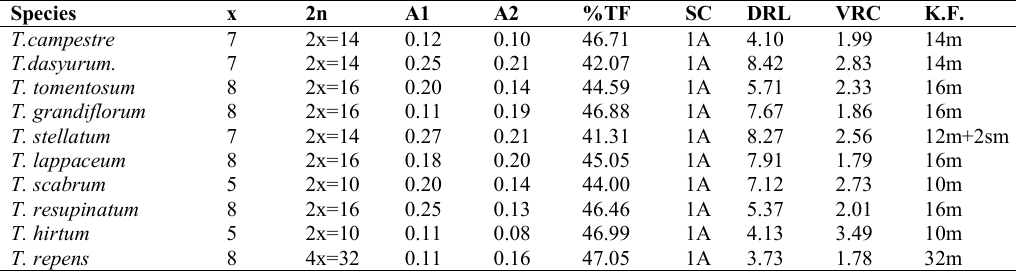
2n=Diploid chromosome numbers; A 1 =Intrachromosome asymmetry index; A 2 =Interchromosome asymmetry index; TF%= total form percentage; DRL=difference of relative length; VRC=value of relative chromatin; SC=symmetry classes of Stebbins; K.F.=karyotype formula.